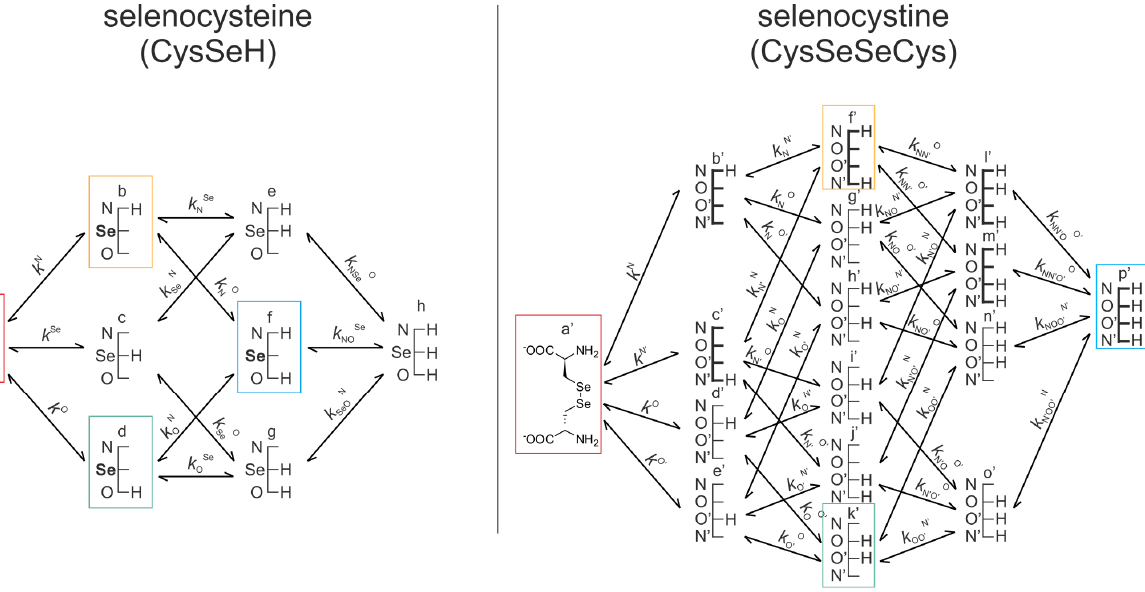
Figure 7. The protonation microequilibrium schemes of selenocysteine ( left ) and selenocystine ( right ). For simplicity, not every protonation microspecies are shown in a structural formula, rather a schematic structure depicts the microspecies with its basic sites where N, Se, and O labels denote the amino, selenolate, and carboxylate groups, respectively. The corresponding species participating in redox equilibria are bordered in color. Reproduced from [49].